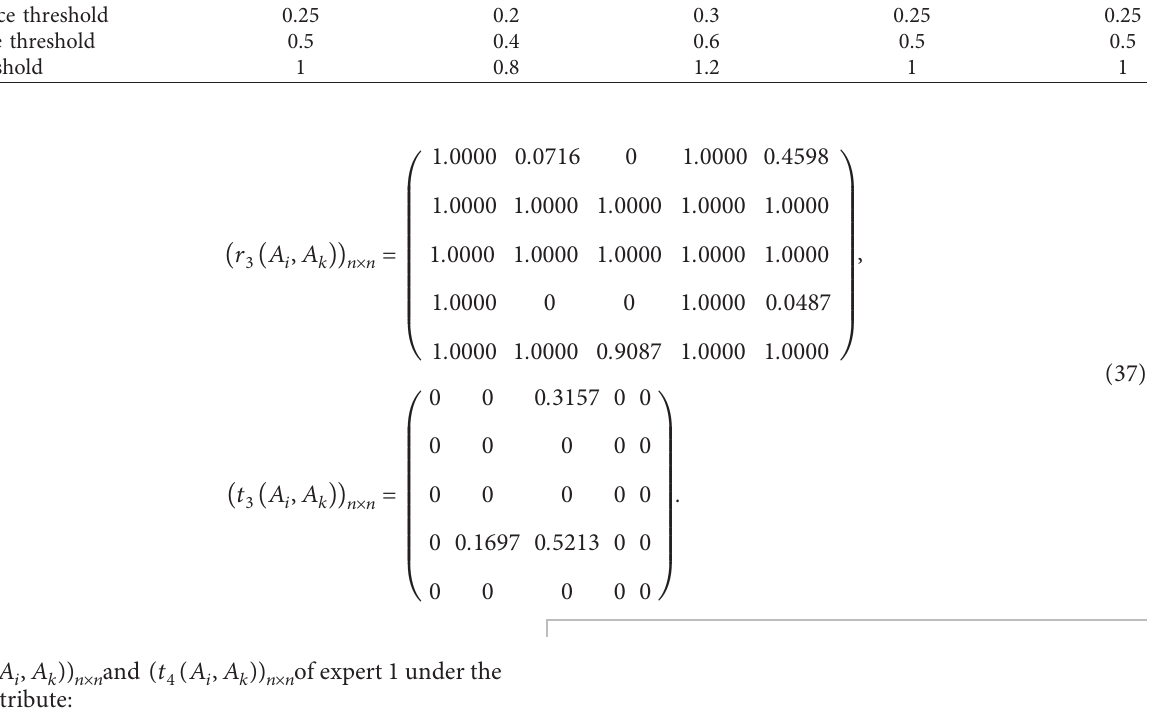
Table 1: The indifference threshold, preference threshold, and veto threshold of the five attributes. Threshold G